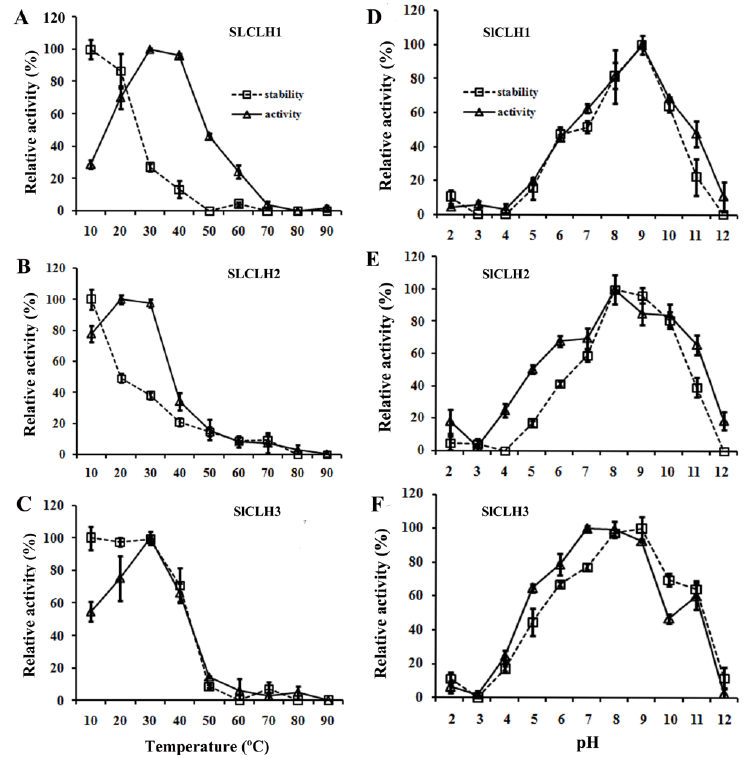
Figure 5. Effect of temperature and pH on the activity and stability of recombinant SlCLH1/2/3 Effect of temperature on the activity and stability of recombinant SlCLH1 ( A ), SlCLH2 ( B ), and SlCLH3 ( C ). The optimal temperature ( △ ) and temperature stability ( □ ) of SlCLH1, SlCLH2, and SlCLH3 were measured according to the standard CLH assay by using Chl a as a substrate. Effect of pH on the activity and stability of recombinant SlCLH1 ( D ), SlCLH2 ( E ), and SlCLH3 ( F ). The optimal pH ( △ ) and pH stability ( □ ) of SlCLH1, SlCLH2, and SlCLH3 were measured according to the standard CLH assay by using Chl a as a substrate. Data represent means ± the standard deviation of three independent experiments.